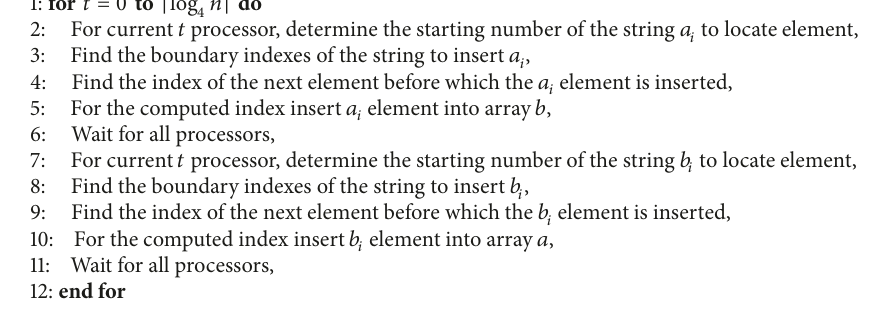
sorted strings of 𝑛/2 elements by 𝑛 independently